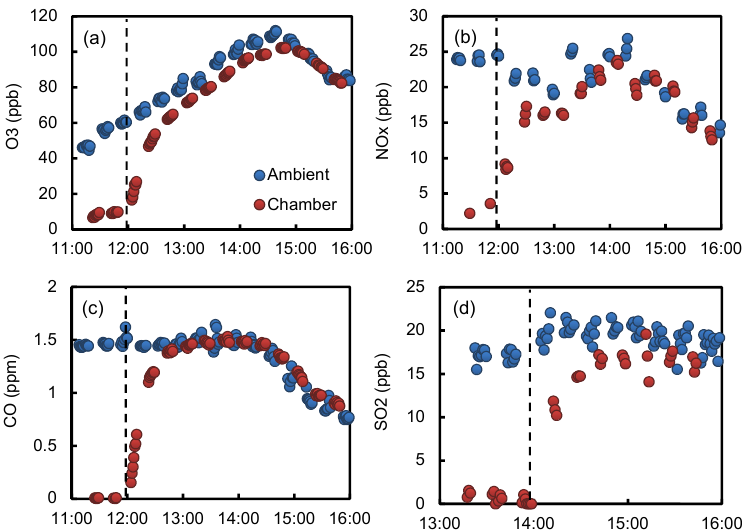
Figure 4. Concentrations of O 3 (a) , NO x (b) , CO (c) and SO 2 (d) measured inside the QUALITY chamber (Red circles) and in the ambient air (blue circles). The vertical dashed lines denote the time when the ambient air started to be pulled through the bottom flow chamber and the ambient gases began to pass into the upper reaction